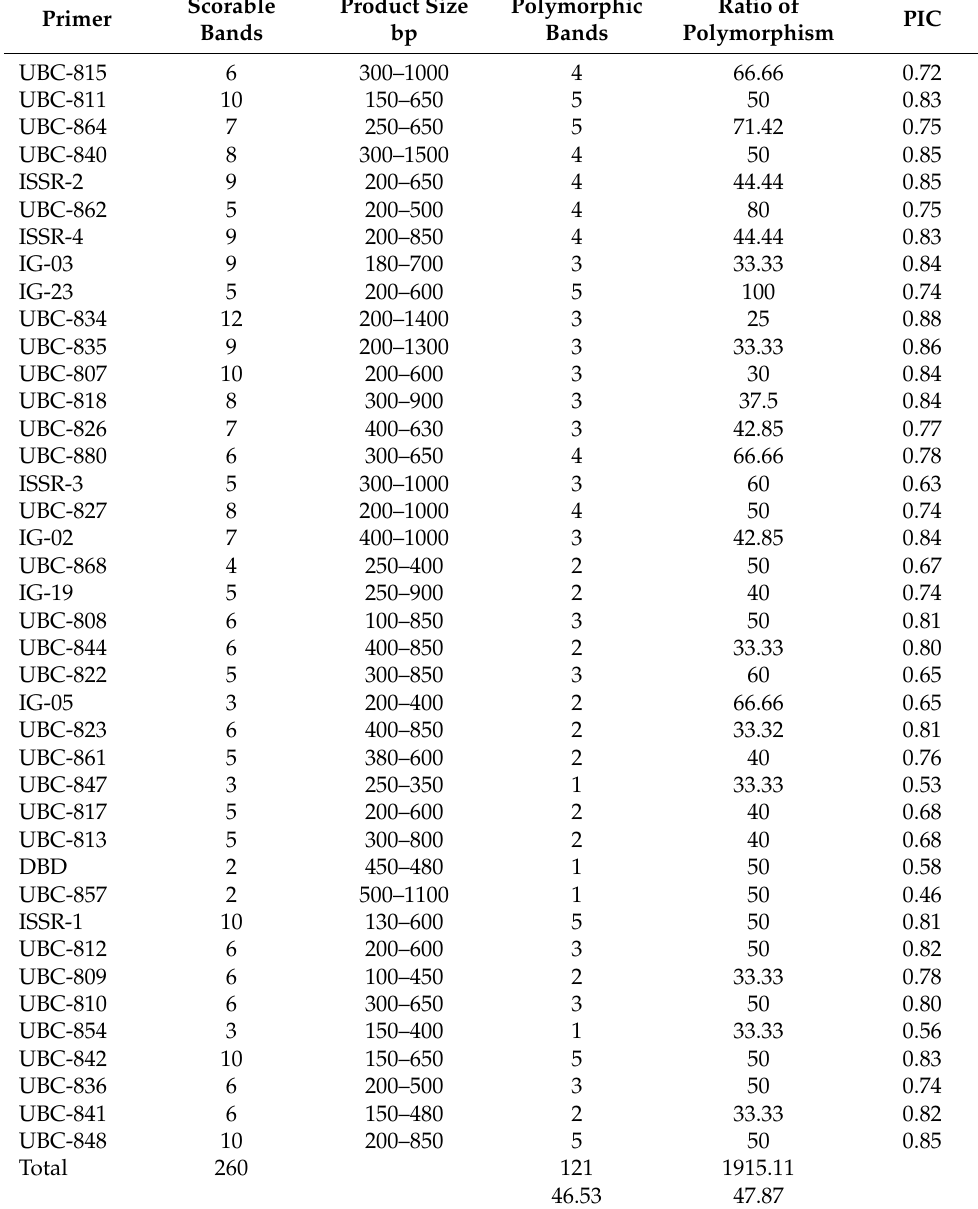
Table 1. Features of ISSR primers used for ISSR − PCR of 14 banana